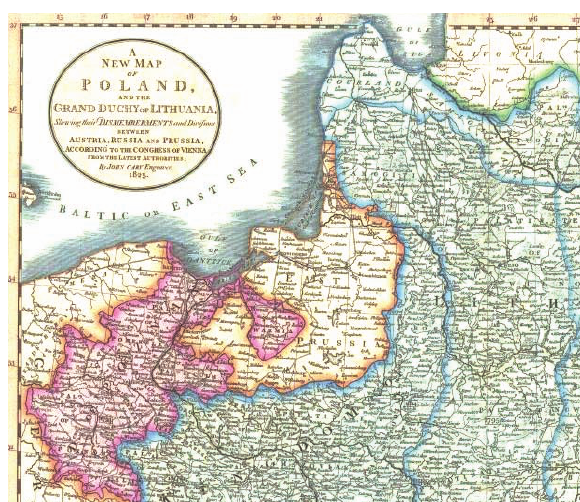
Fig. 12. Fragment Perthee‘s map of Poland, 1773